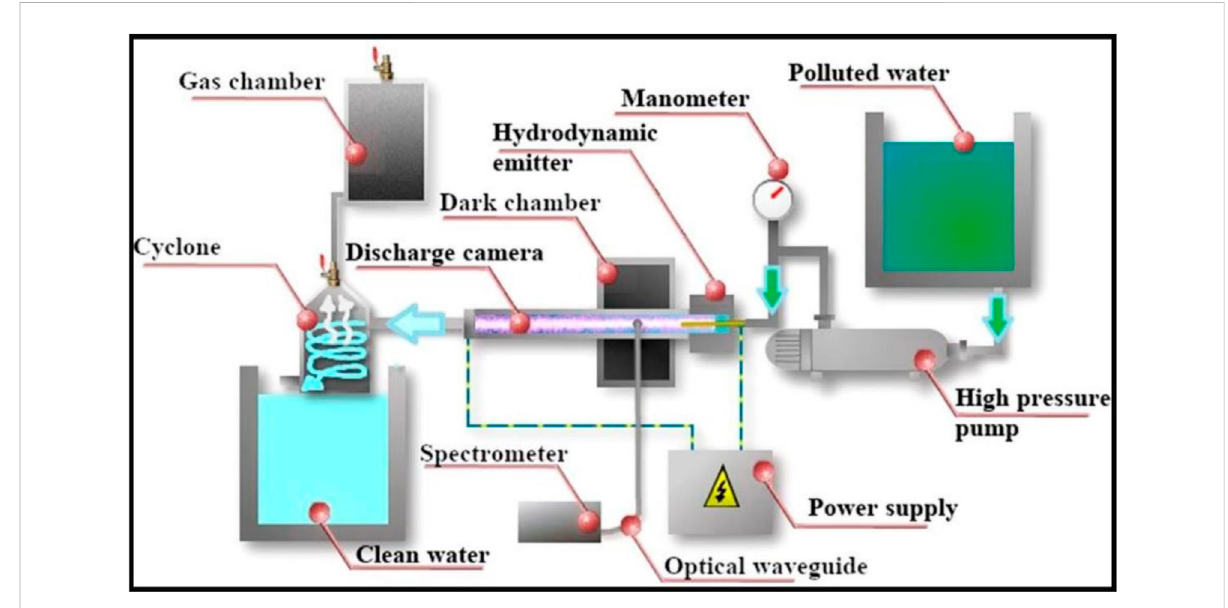
FIGURE 15 Hydrodynamic and plasma discharge: Laboratory set-up for useful for advanced oxidation process (AOP). Reprinted with permission from (Abramov et al., 2021). Copyright (2021) Elsevier.